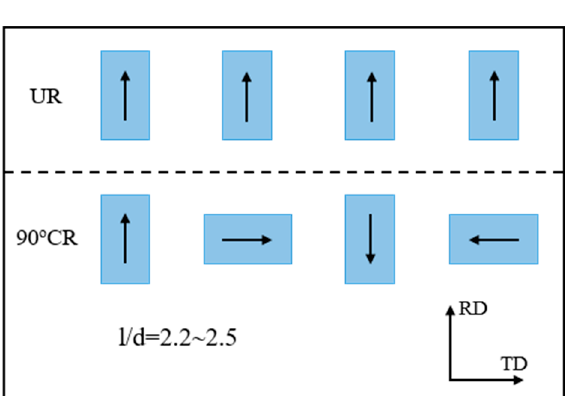
Figure 1. Schematic diagram of sample rolling method.